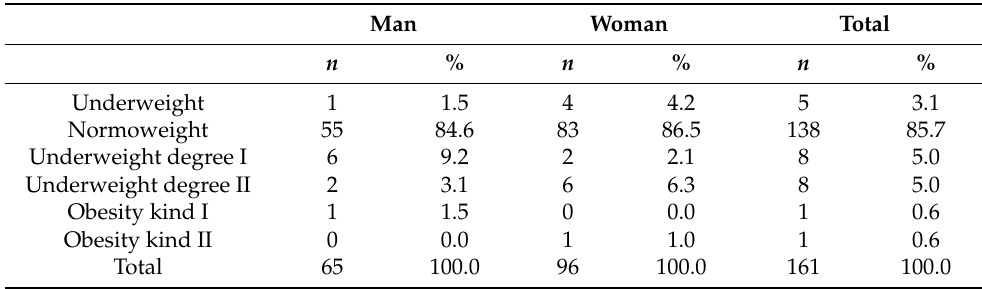
Table 1. Distribution of university students according to the BMI classification criteria proposed by the Spanish Society for the Study of Obesity (SEEDO).